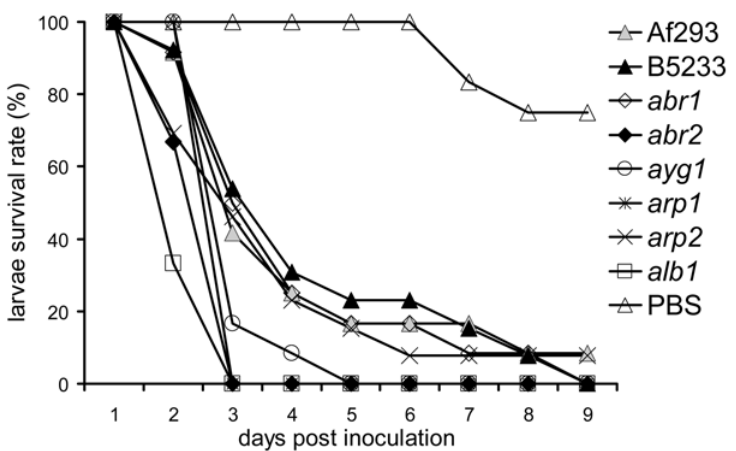
Figure 2. A.fumigatus defined color mutants in the B5233 background show enhanced virulence in the G.mellonella model. Larvae were inoculated with A. fumigatus at concentrations of 1 6 10 6 conidia per caterpillar. The G. mellonella survival versus days post inoculation was plotted. Wild type strains Af293 and B5233 have similar virulence (p=0.9601), while color mutants abr2 (p=0.0017), ayg1 (p=0.0009), arp1 (p=0.0050), arp2 (p=0.0407), and alb1 (p , 0.0001) have increased virulence compared to the wild type strain. Only the color mutant abr1 (p=0.1841) does not have a statistically significant difference in virulence from the wild type strain. Twelve caterpillars were inoculated per A. fumigatus strain and studies were repeated three times for each strain and similar pattern was observed.